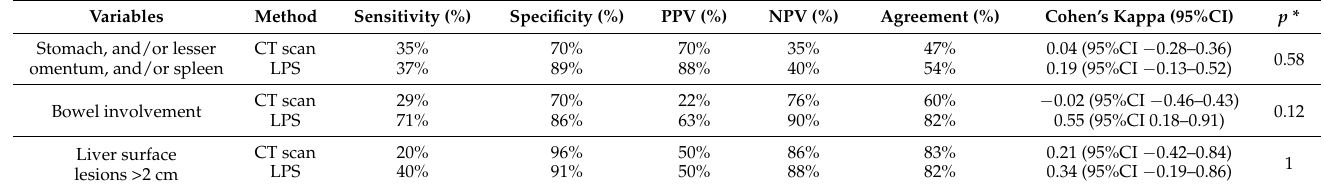
Table 4. Concordance between modified predictive index (PI) scores at computed tomography (CT) scan and laparoscopy (LPS) in women who underwent interval debulking surgery. PPV: positive predictive value; NPV: negative predictive value; CI: confidence interval.